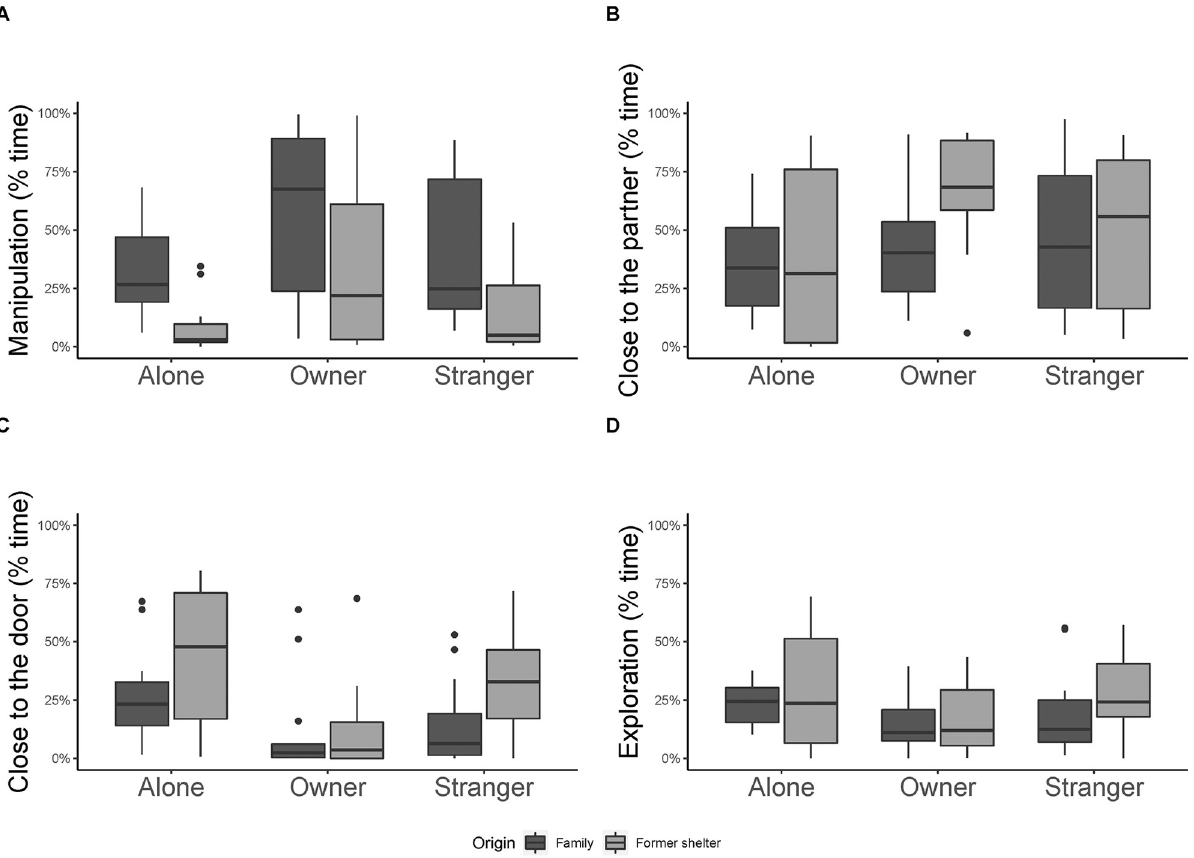
Fig 3. Percentage of time spent showing the behaviours analysed in Experiment 2. Percentage of time spent A) manipulating the object; B) close to the partner; C) close to the door; D) exploring in Experiment 2. Median and interquartile range (IQR; represented by the box), 25th percentile + 1.5 IQR, and 75th − 1.5 IQR (represented by the lower and the upper whiskers